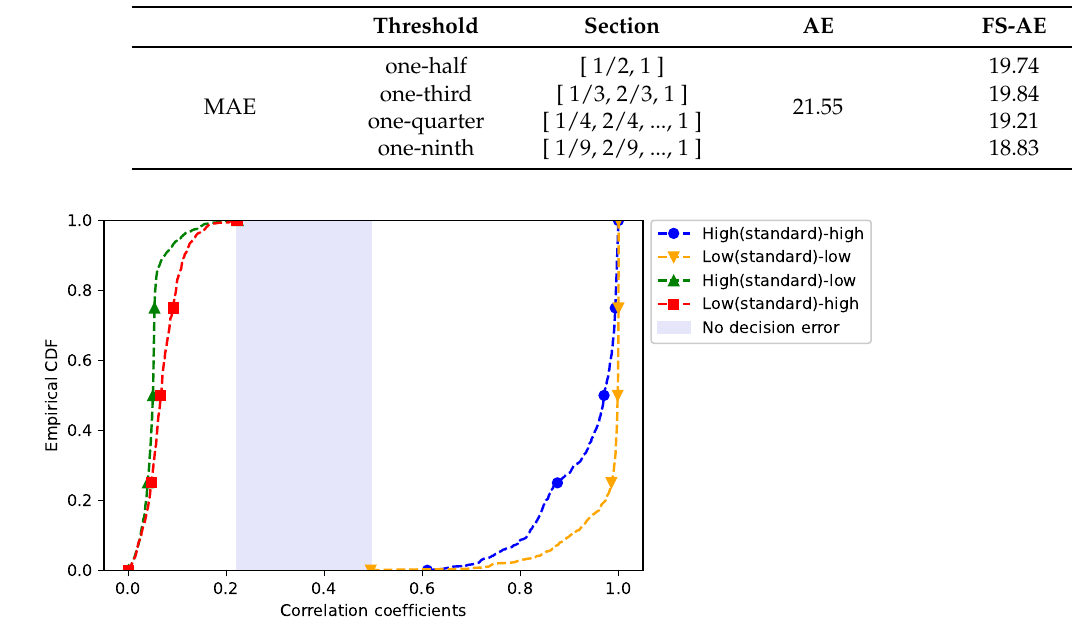
Table 6. Reconstruction performance based on the number of separated sections.